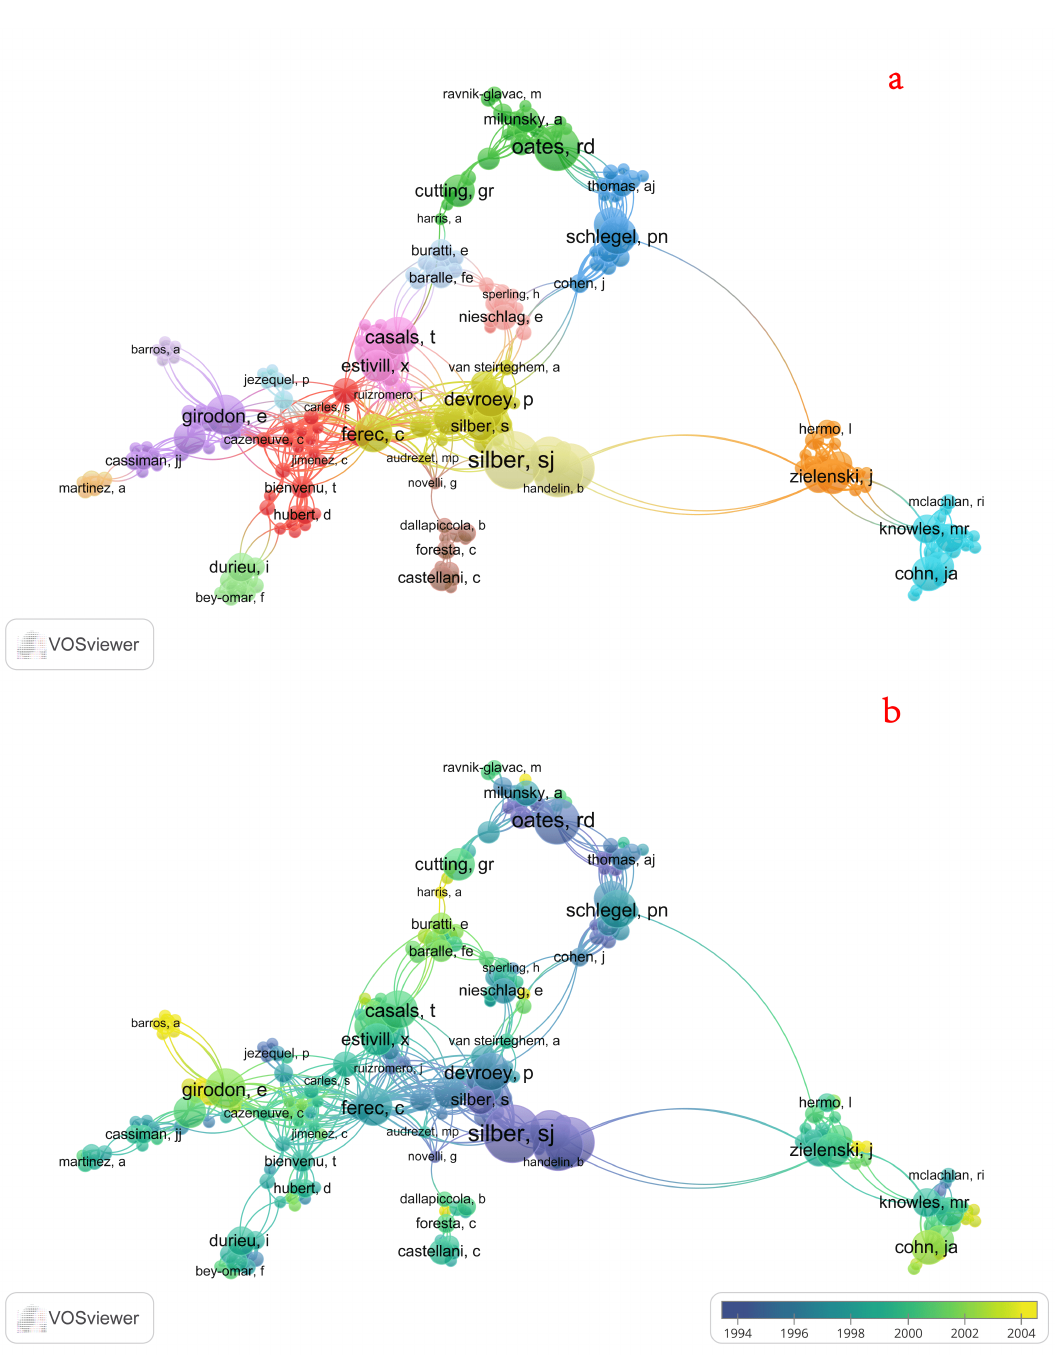
Fig. 6. The font size of each author’s name represents the number of articles. The thickness of the curved connecting line represents the collaborative intensity between authors. (a) The authors collaboration network of AVD research. (b) Different colors inside the circle represent different time